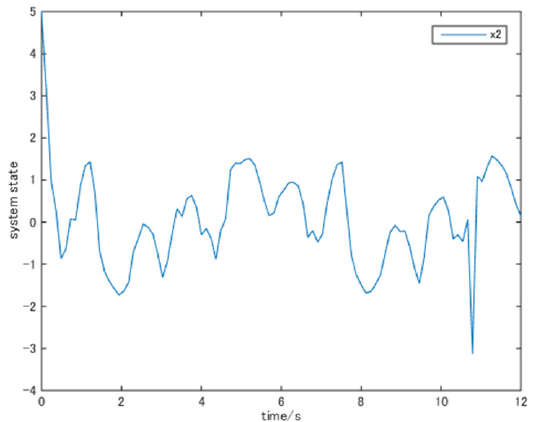
Figure 3. The trajectory of state